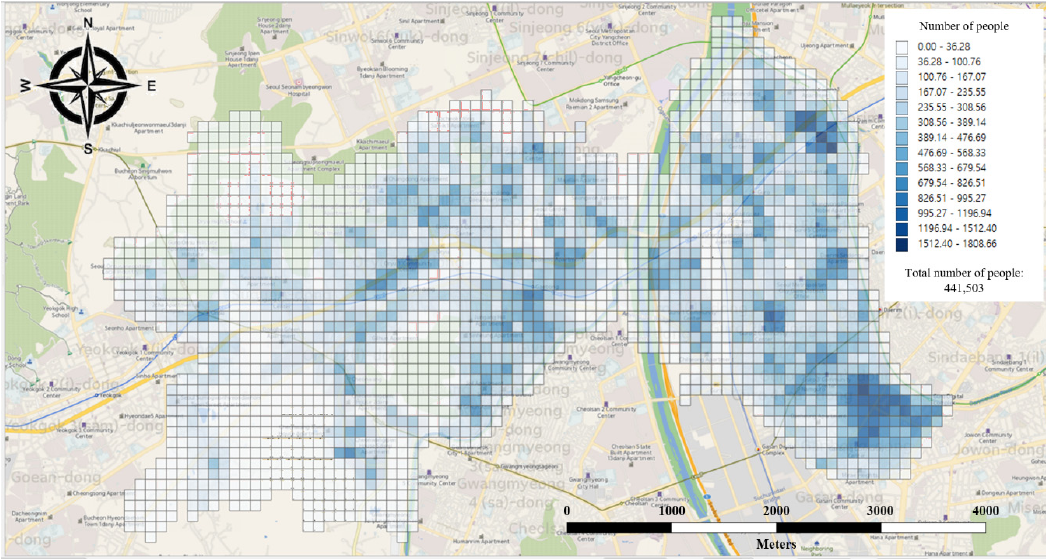
Figure 8. Spatial variation of the total number of people in Guro-gu.